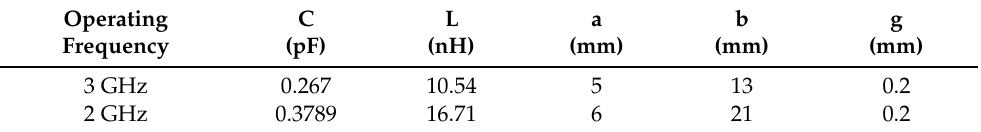
Table 3. Lumped values and physical dimensions of DGS sections ( ε r = 2.97, H = 0.76 mm).